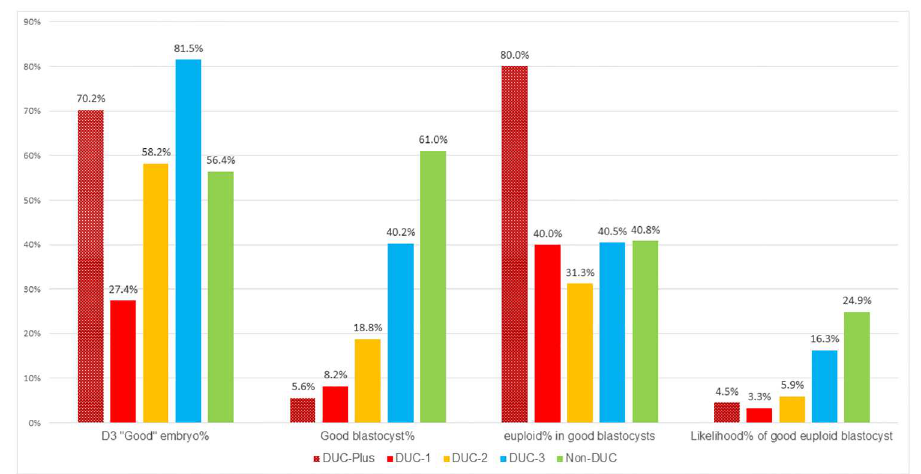
Fig 3. Estimated likelihood of DUC embryos development into good euploid blastocyst. DUC-1: direct unequalcleavageat 1 st cleavage;DUC-2: direct unequal cleavageat 2nd cleavage;DUC-3: direct unequal cleavageat 3 rd cleavage;DUC-Plus: DUC occurred more than once. Non-DUC: embryos without